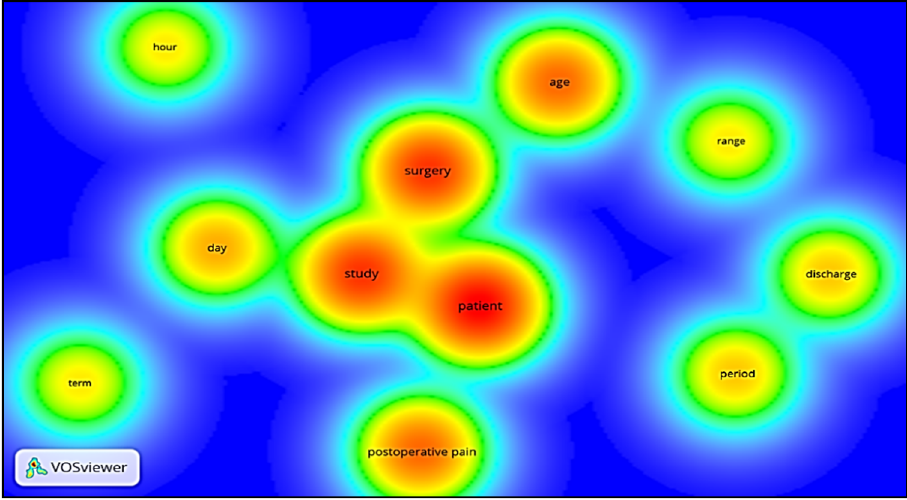
Figure 9. Word density visualization.